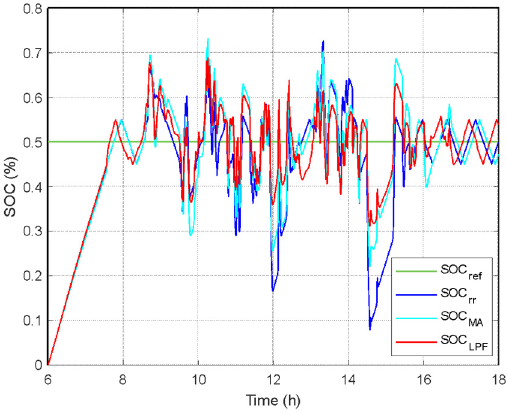
Figure 10. State of charge (SOC) of the storage system, the most critical day.